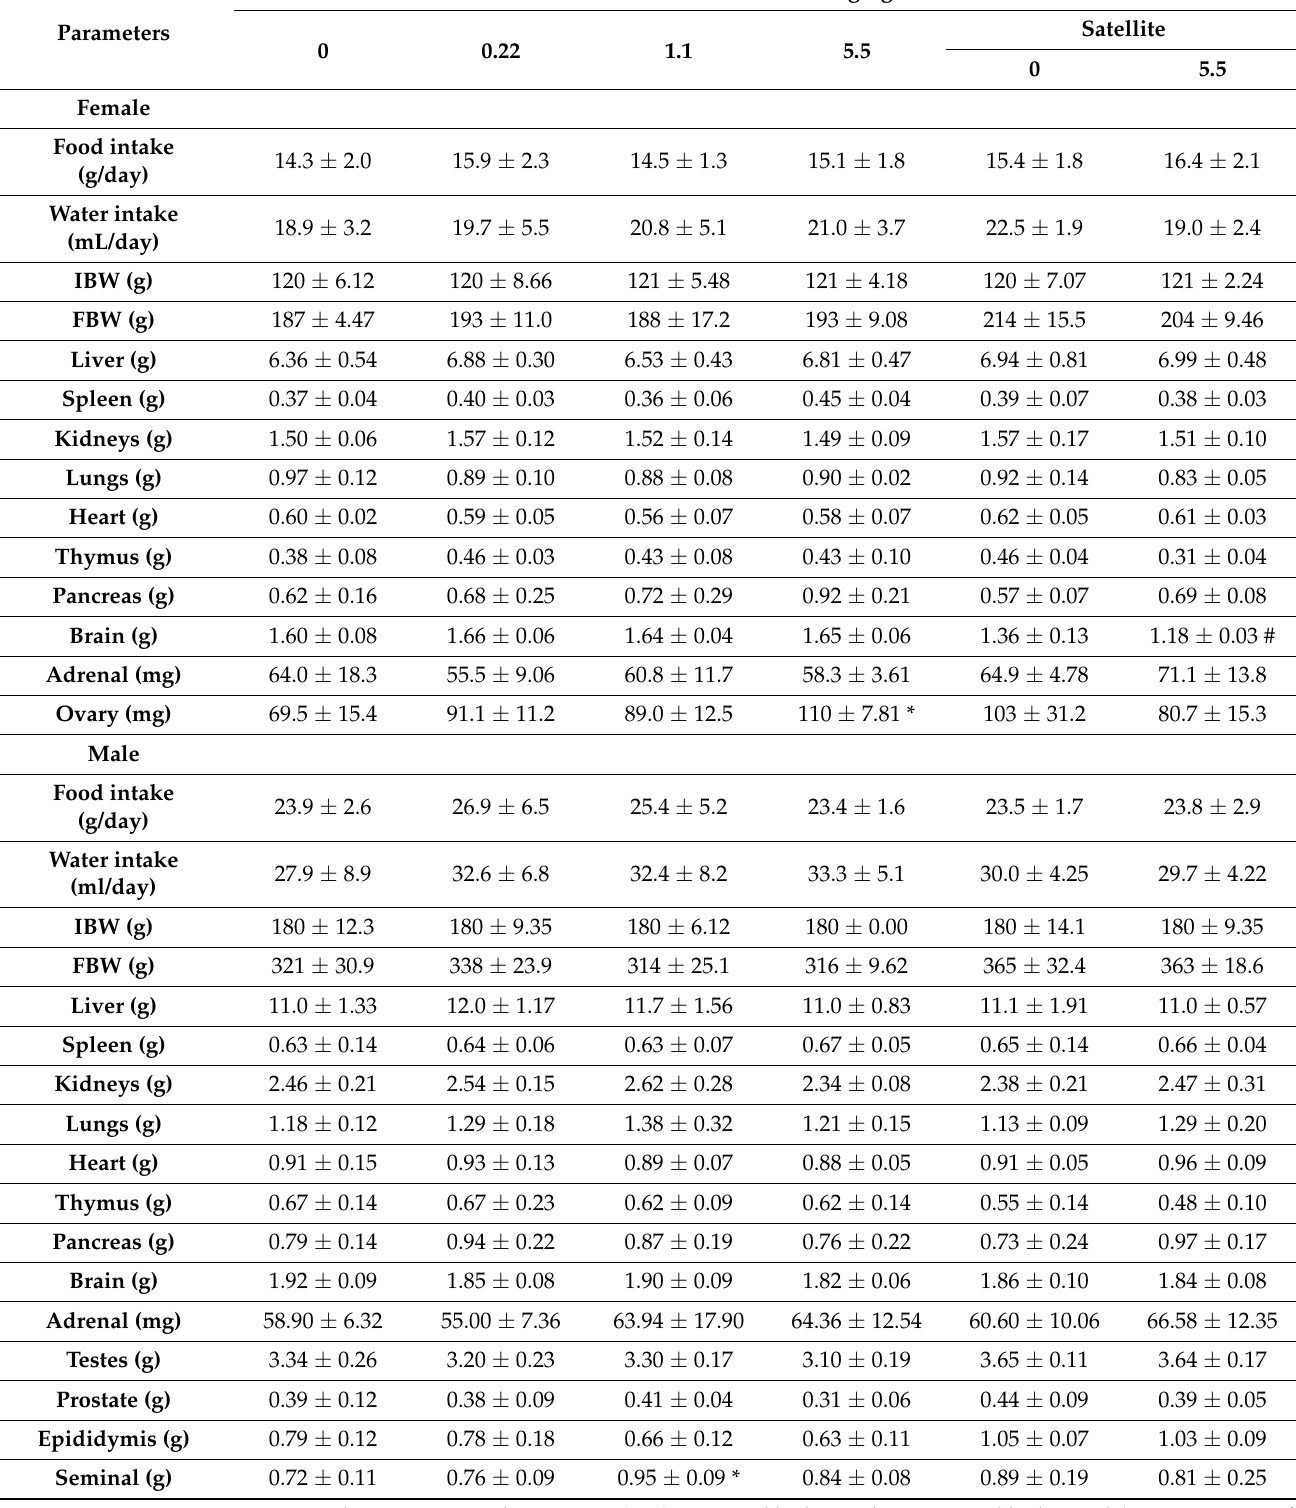
Table 1. Effect of 28-day administration of Fe-TA NPs on general observation and organ